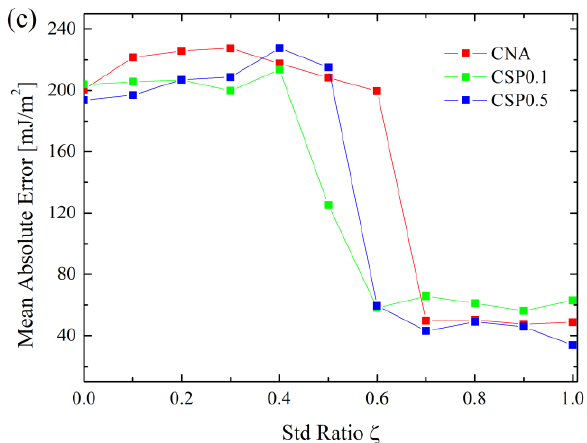
Figure 5. MAE of RNN prediction vs. 𝜁 of three GB atom selection methods for ( a ) Cu, ( b ) Al and ( c ) Ni.